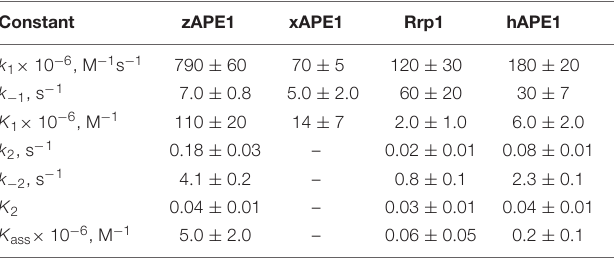
TABLE 3 | Rate and equilibrium constants of the interaction of AP endonucleases with the nondamaged DNA as determined by nonlinear least-squares regression analysis of the FRET